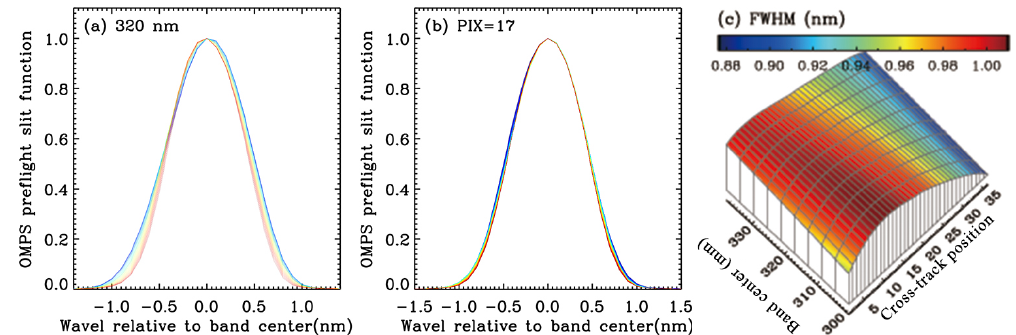
Figure 1. (a) OMPS preflight slit function at 320nm band center, with colors representing different cross-track positions from 1 (blue) to 36 (red). (b) Same as (a) but for the 17th cross-track position, with colors representing different wavelengths from 300 (blue) to 340nm (red). (c) Full width at half maximum (FWHM) in nm as functions of cross-track positions ( x axis) and band center wavelengths ( y axis) ranging from 300 to